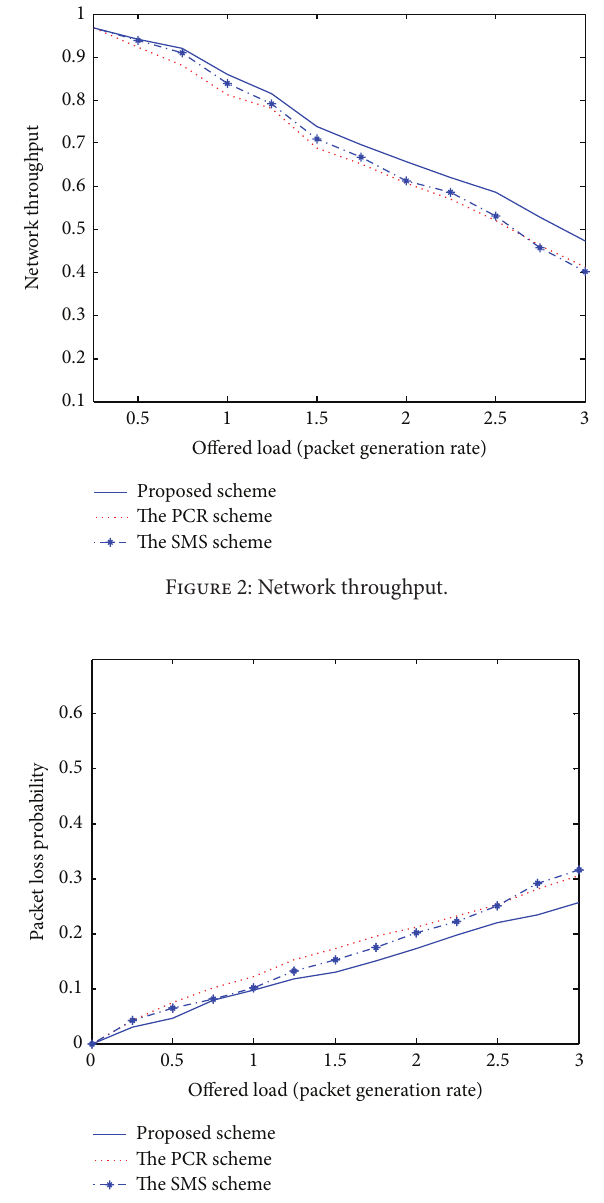
Figure 3: Packet loss